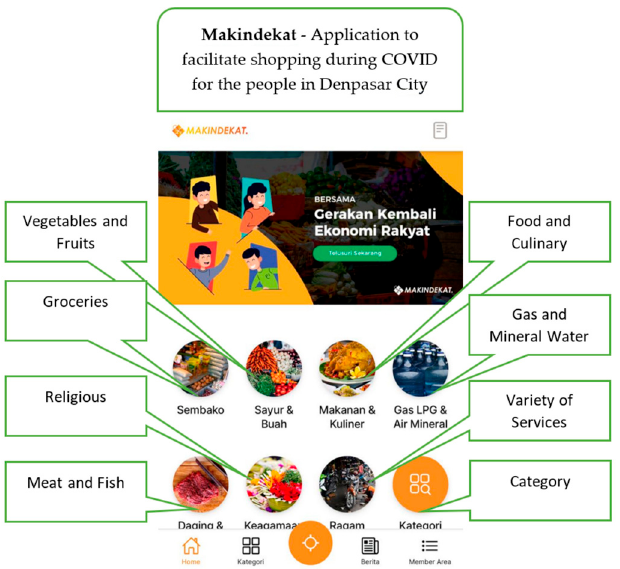
Figure 5. The appearance of the application “Makindekat”. Source: Researcher’s documentation,